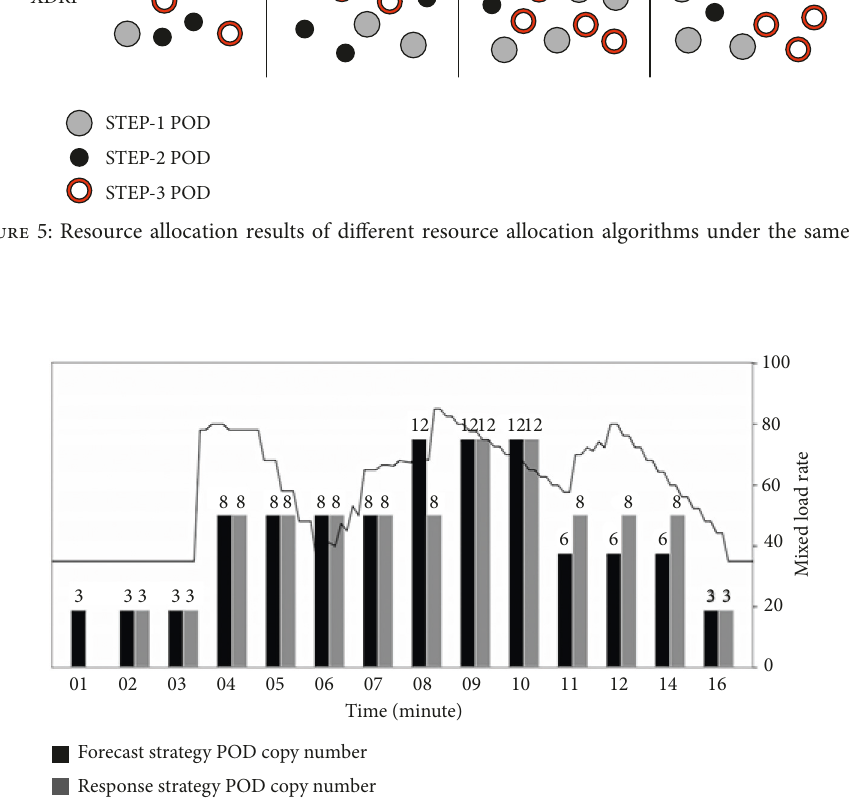
Figure 6: Comparison diagram of automatic capacity expansion effect of XEDI under different